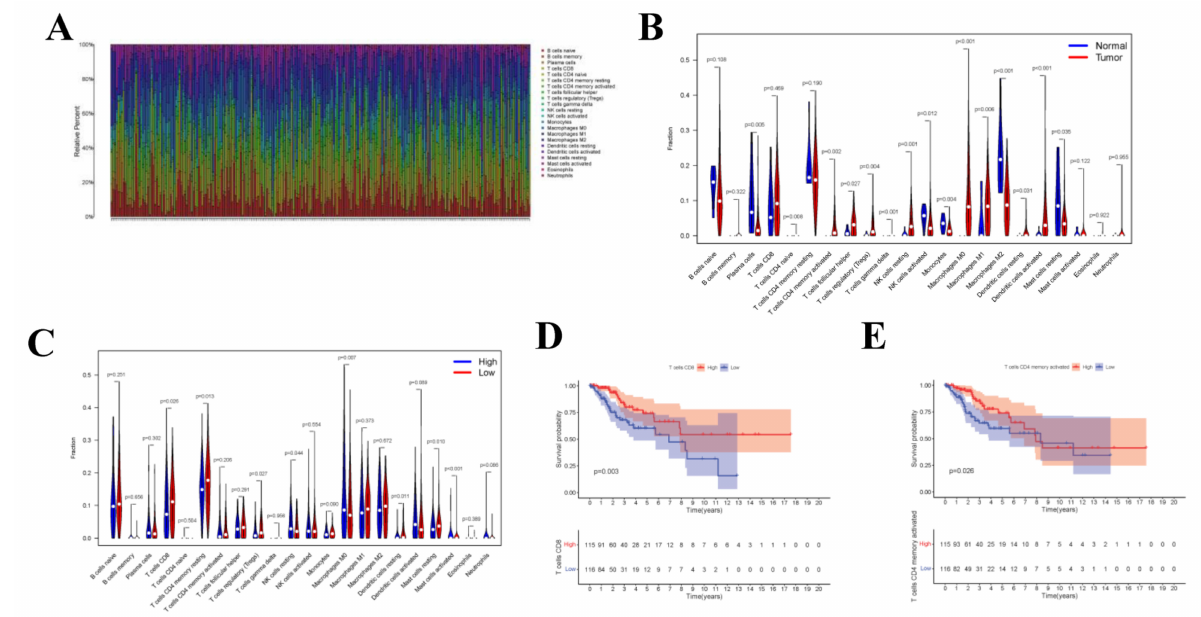
Figure 8. CIBERSORT Estimation and Survival Analysis. The composition ( A ) of immune cells estimated by the CIBERSORT algorithm in 13 normal adjacent tissues and 304 CESC tissues. The violin plot of immune cells ( B ) compares cells’ proportion between the two groups. The violin plot of immune cells ( C ) compares cells’ proportion between the gene high-risk and low-risk groups. ( D , E ) The K–M survival curves of immune cells, where showed genes significantly correlated with prognosis ( p <